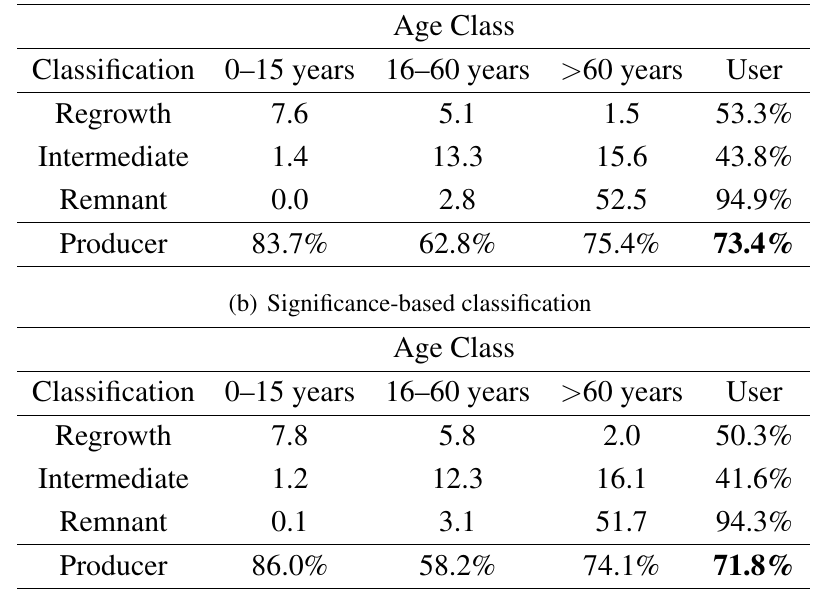
Table 2. Validation of regrowth stage classification derived from ALOS PALSAR FBD data and Landsat derived FPC compared to the age class map of [6], derived from manual interpretation of time series of aerial photography and SPOT HRG data. Data were classified using ( a ) the maximum-likelihood classification and ( b ) the significance-based classification (using a z -test), with both applied at the object level. Values are expressed as percentage of the total intersect area between the two classifications, to account for different polygon